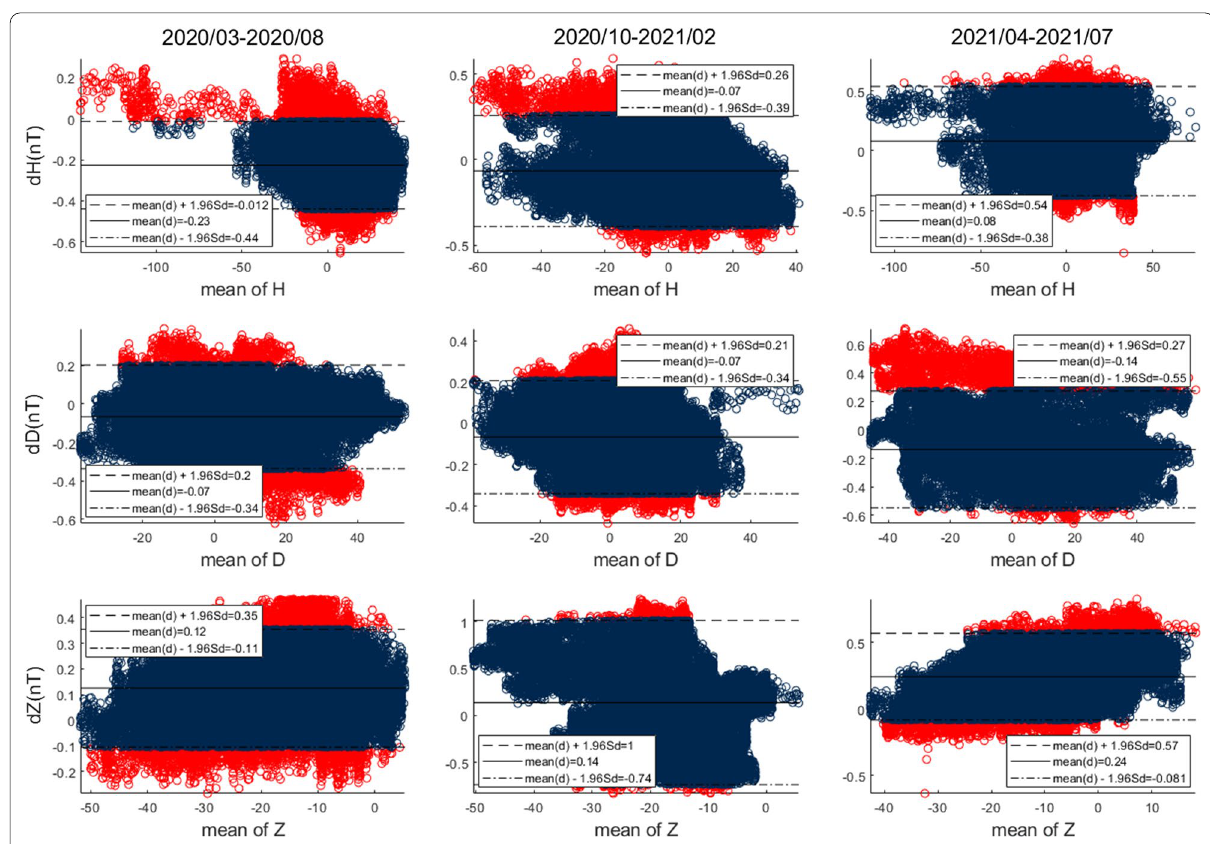
Fig. 10 B–A plots of three long-term